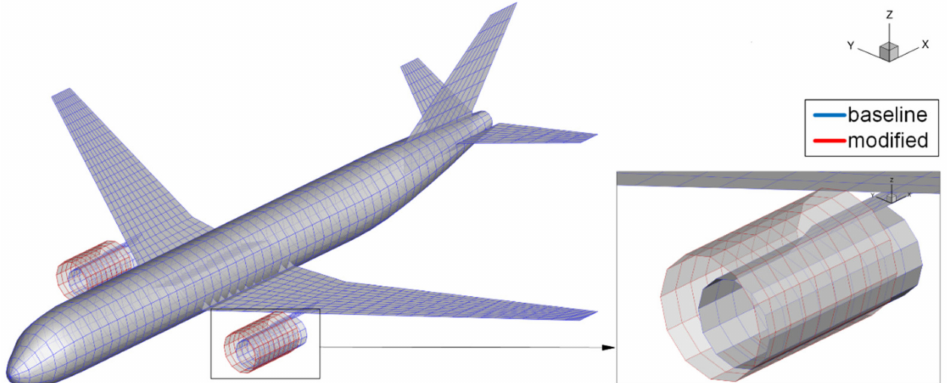
Figure 10. Used aerodynamic panel model of the two variants for the flutter analysis within